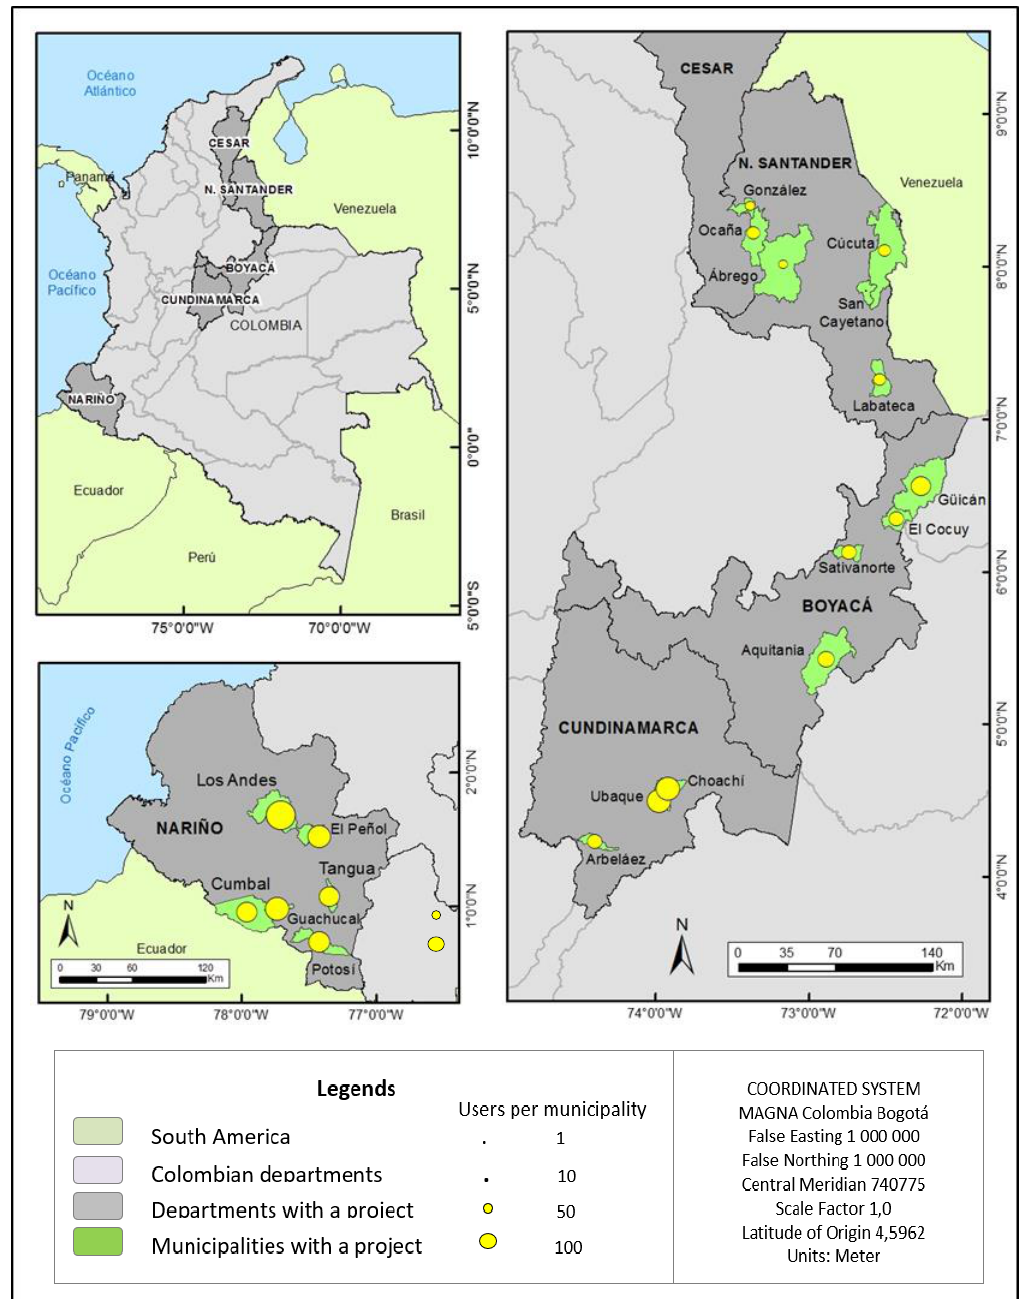
Figure 2. Study area by departments and municipalities showing the number of users among the organizations of irrigation districts. organizations of irrigation